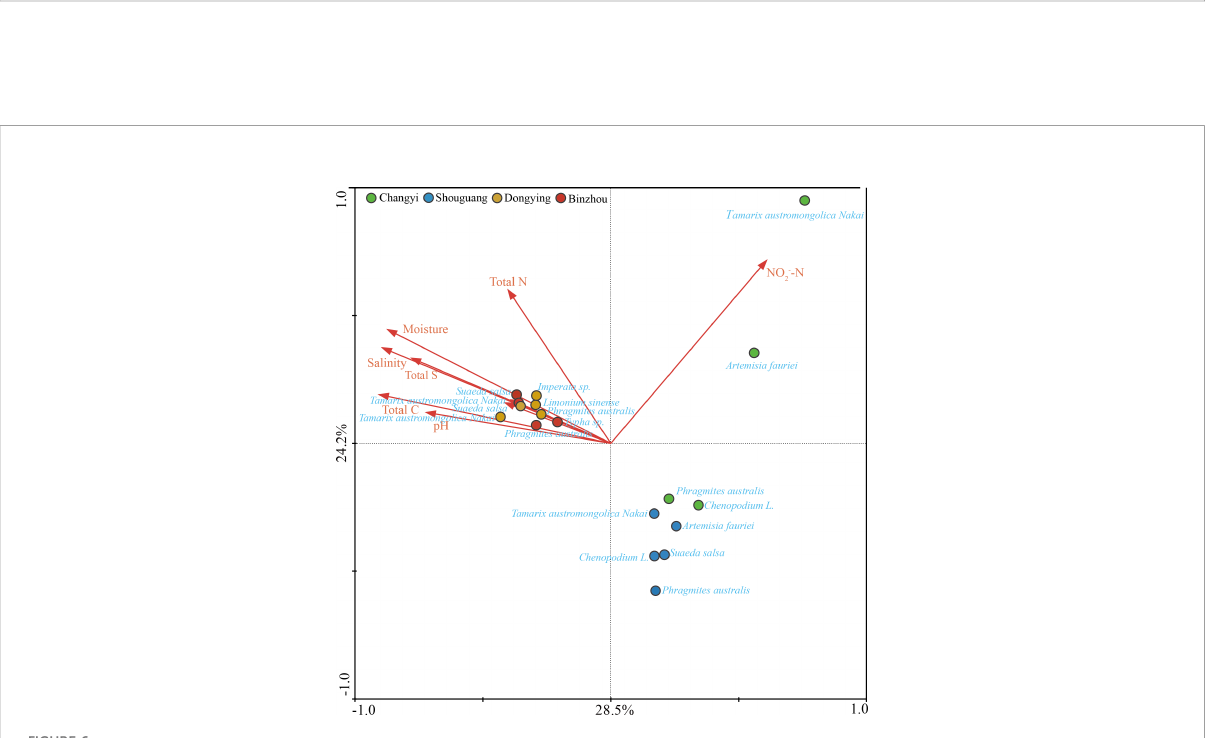
FIGURE 6 Canonical correspondence analysis (CCA) based on diazotrophic microbes and environmental parameters in different plant host habitats at Changyi (CY), Shouguang (SG), Dongying (DY) and Binzhou